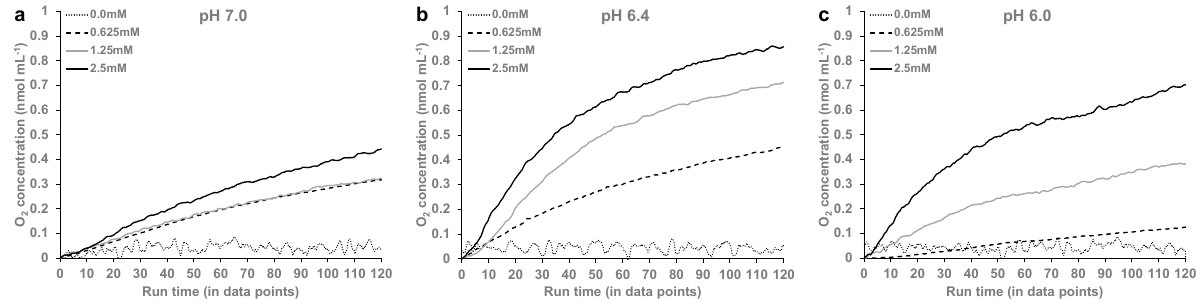
Figure 5. The O 2 release at varying concentrations (0.0 mM, 0.625 mM, 1.25 mM, and 2.5 mM) of LAC at ( a ) pH 7.0, ( b ) pH 6.4, and ( c ) pH 6.0. The rate of O 2 release was calculated from the linear portion of the graphs immediately after addition of LAC to oxy-Mb. Representative data from a single experiment per condition are shown here. All O 2 kinetic experiments were repeated 3 times ( n = 3).